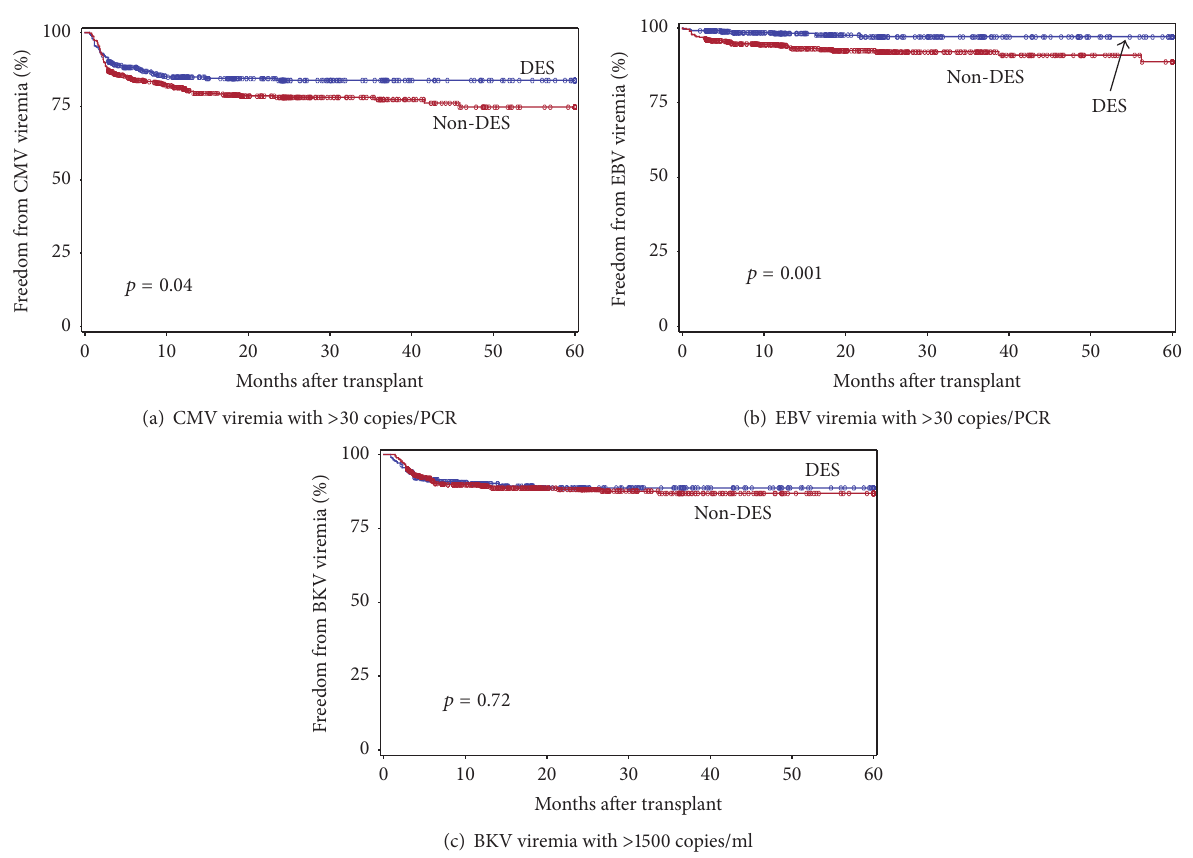
Figure 2: Freedom from CMV (a) or EBV (b) viremia with > 30 copies/PCR and BKV (c) viremia with > 1500 copies/ml in DES (blue) and non-DES (red) patients during the 1st 5 years after transplant. The group differences were assessed by the log-rank test.